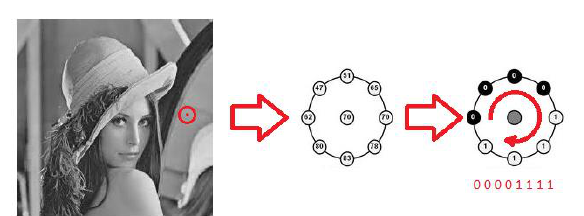
Figure 4. An example of LBP descriptor calculation for a point in the